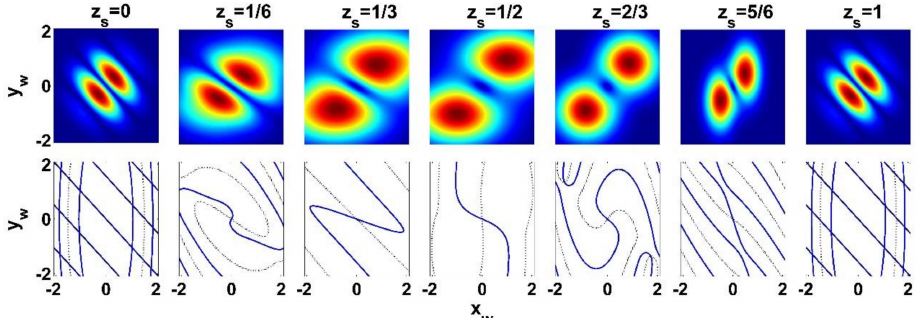
Figure 3. Evolution of field distributions of a sin-Gaussian beam with the scaled propagation distance z s for z p = z R , β x = β y = 2, R 0x = 3 z R /4, R 0y = 10 z R . Upper row: Intensity distribution | E ( x , y , z )| 2 ; Bottom row: Re{ E ( x , y , z )} = 0 (solid lines) and Im{ E ( x , y , z )} = 0 (dashed lines),